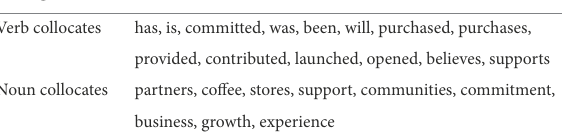
TABLE 2 Most frequent verb and noun collocates of ‘Starbucks’.